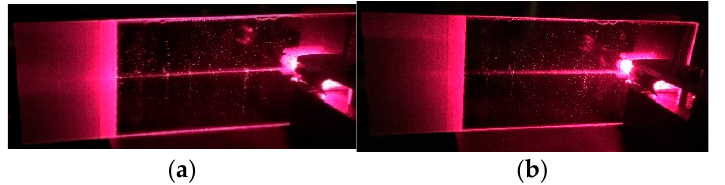
Figure 14. Images of the excited slab waveguides. ( a ) TM 0 mode, ( b ) TE 0 mode, λ = 676.7 nm.